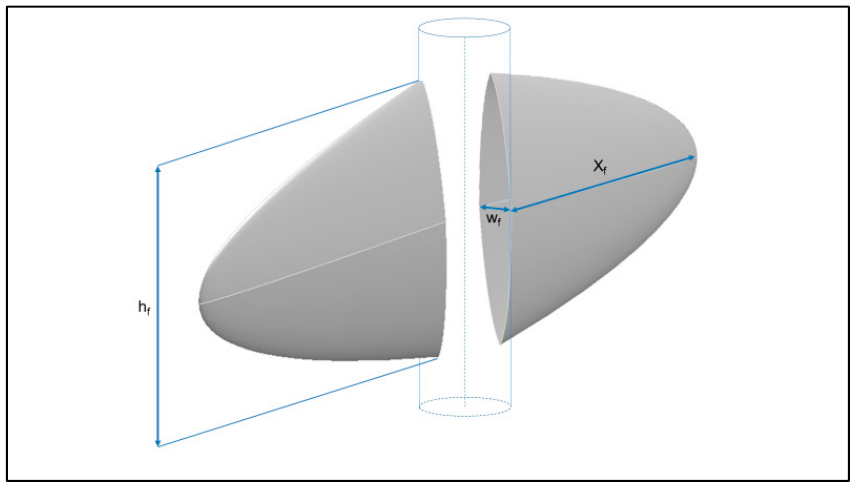
Figure 1. Elliptical bi-wind fractures in a vertical well [28] (p.